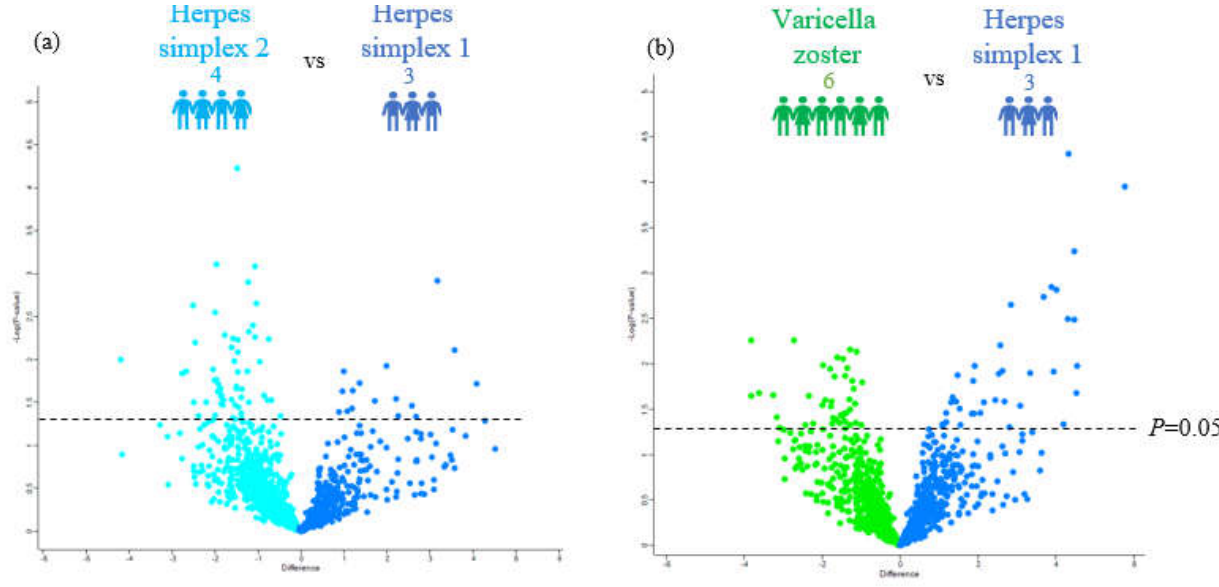
Figure 2. CSF proteome changes in herpes viruses. ( a ) Volcano plot analysis of three HSV-1- (blue) and four HSV-2-infected patients (turquoise) with a p value cut off of 0.05 (i.e., equivalent to − log 10 of 1.3). ( b ) Volcano plot analysis of three HSV-1- (blue) six VZV-infected patients (green) with a p value cut off of 0.05 (i.e., equivalent to − log 10 of